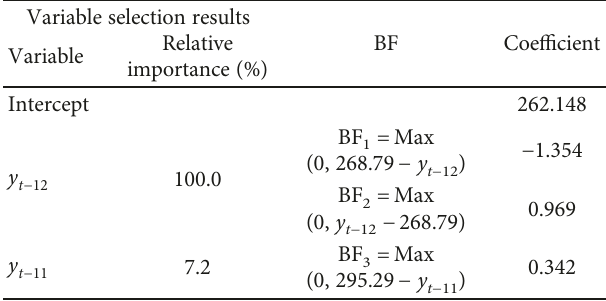
for corn price forecasting. 1